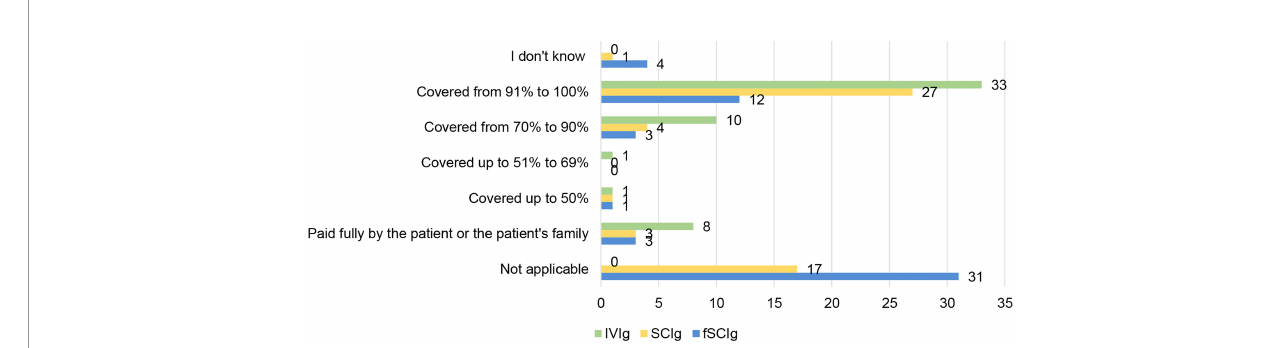
FIGURE 7 | Reimbursement of Ig routes for patients with PIDs (in % of the costs) (n=53, n=53, n=54).